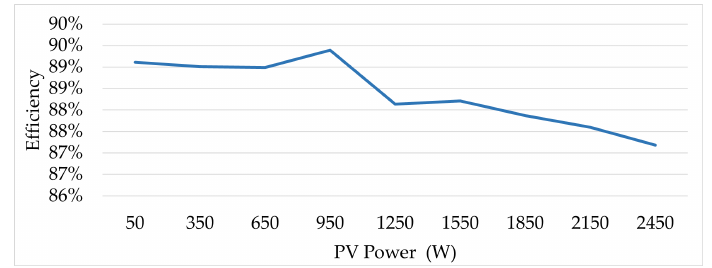
Figure 23. Efficiency versus PV power for operation mode 4.